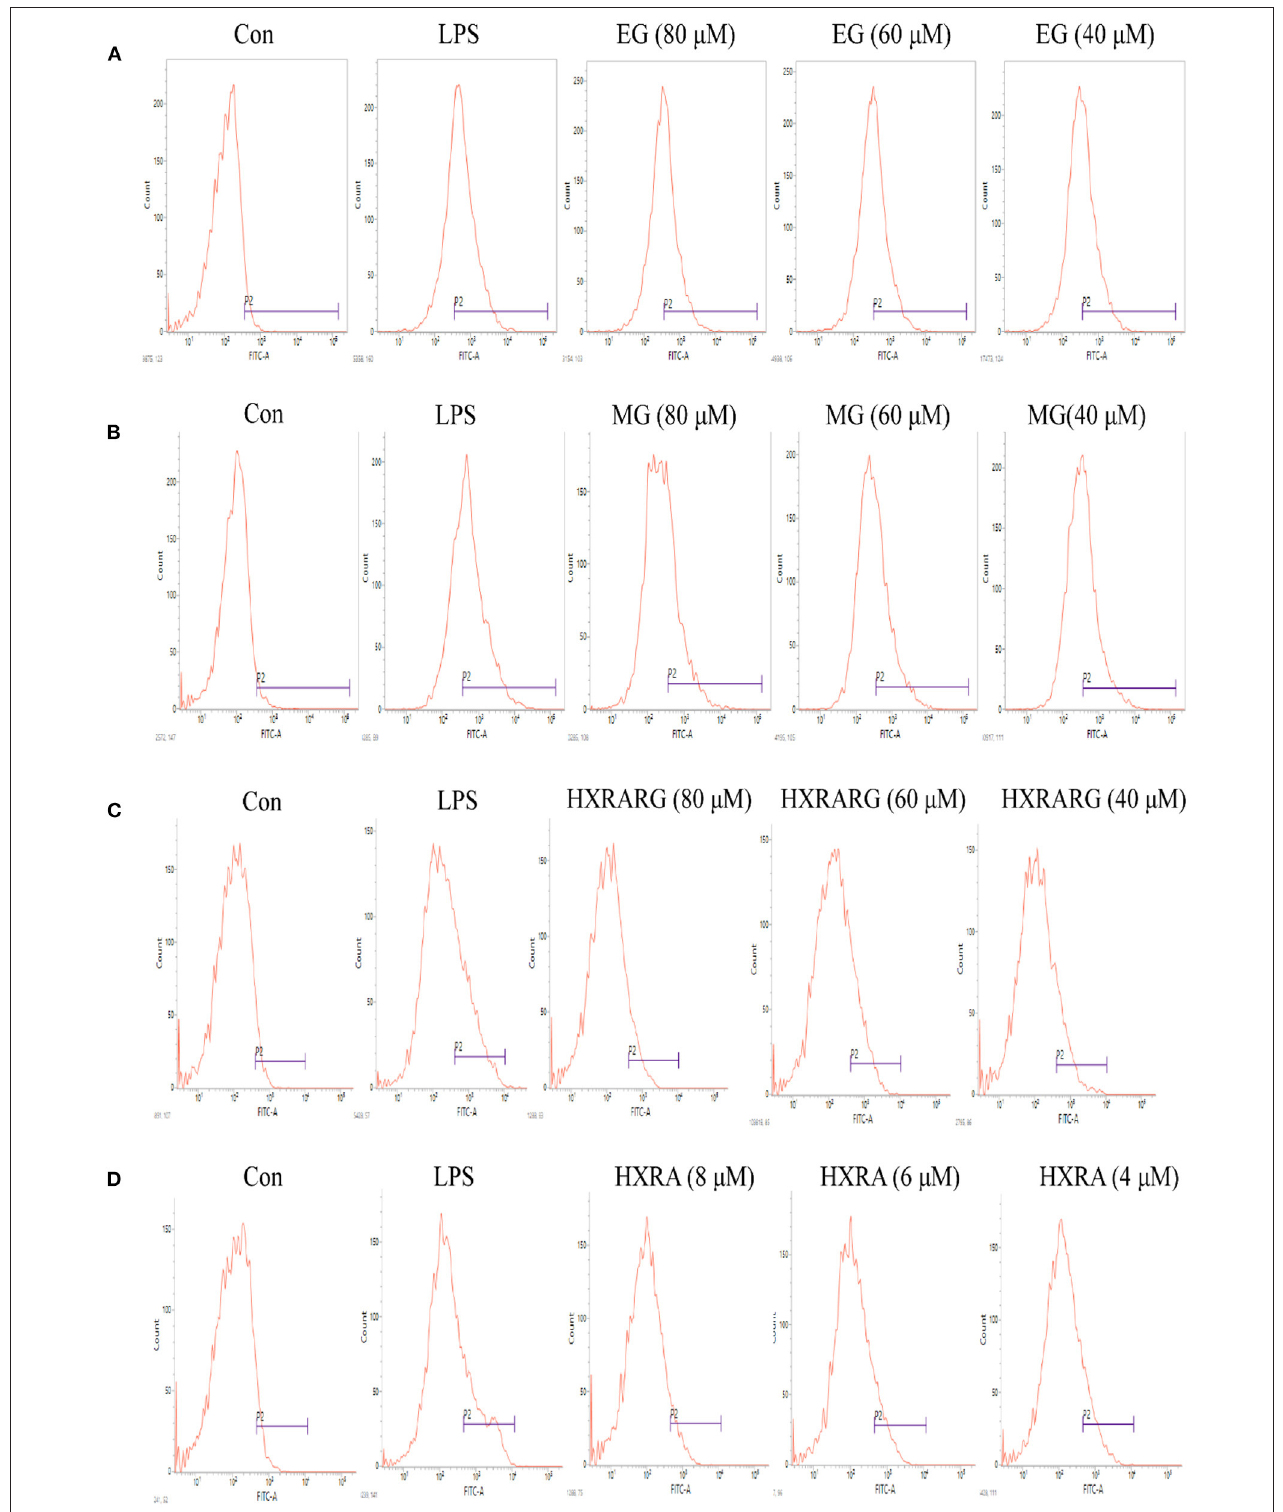
FIGURE 7 | Effect of different concentrations of EG (A) , MG (B) , HXRARG (C) , and HXRA (D) on ROS production ability of RAW 264.7 cells.